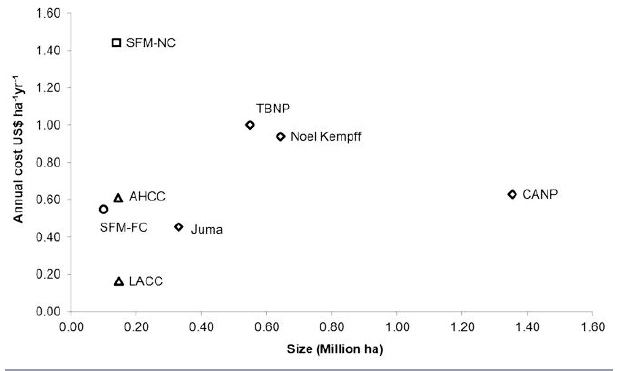
Fig. 2 . Average transaction costs of the six Peruvian projects (discounted at 3.8%), the Brazilian and Bolivian REDD+ projects in relation to project area (diamonds = protected areas; triangles = conservation concessions; circle = forestry concession; square = indigenous land). Project acronyms are defined in Figure